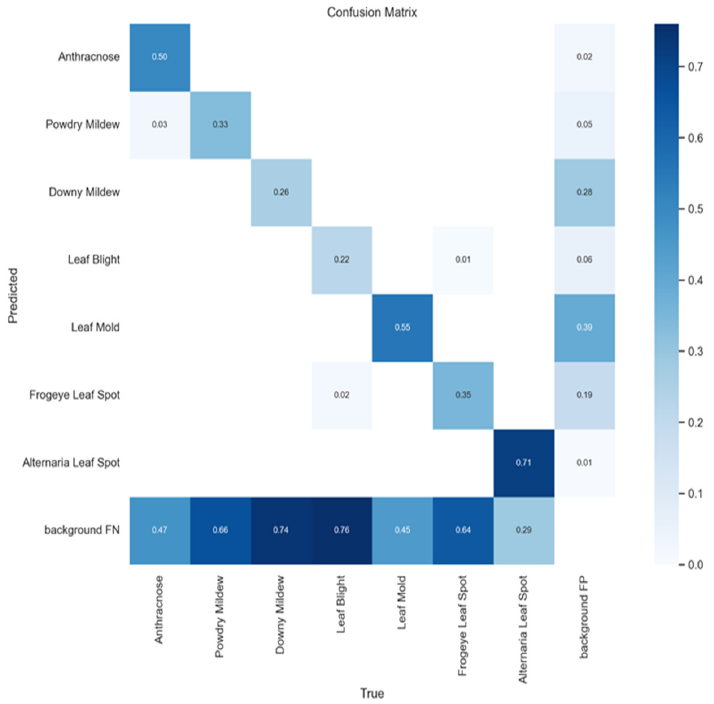
Figure 11. Confusion Matrix of Object Detection Model.